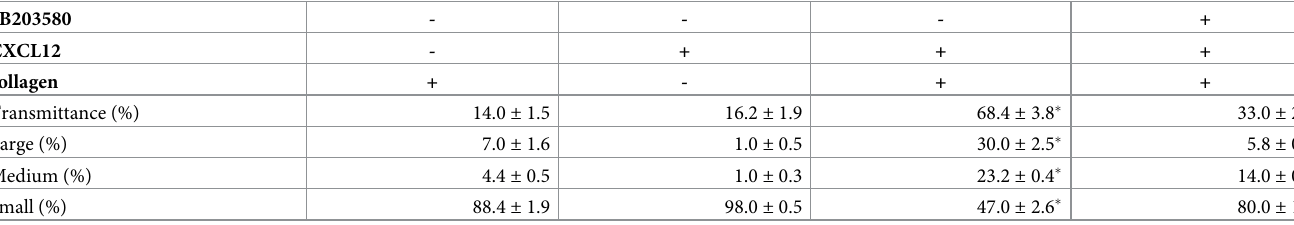
Table 1. Effect of SB203580 on platelet aggregation by low doses of collagen and CXCL12.